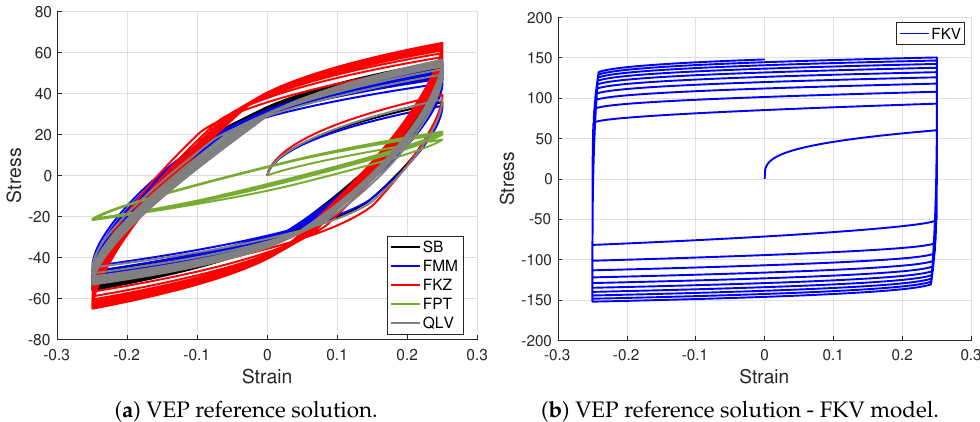
Figure 8. Visco-elasto-plastic reference solutions for the employed models for the first 30 loading cycles. We noticed a similar behavior for most models under the choice of material parameters except for the FPT and FKV models. The FKV particularly yielded a very stiff response due to the combination of high fractional order values and high strain